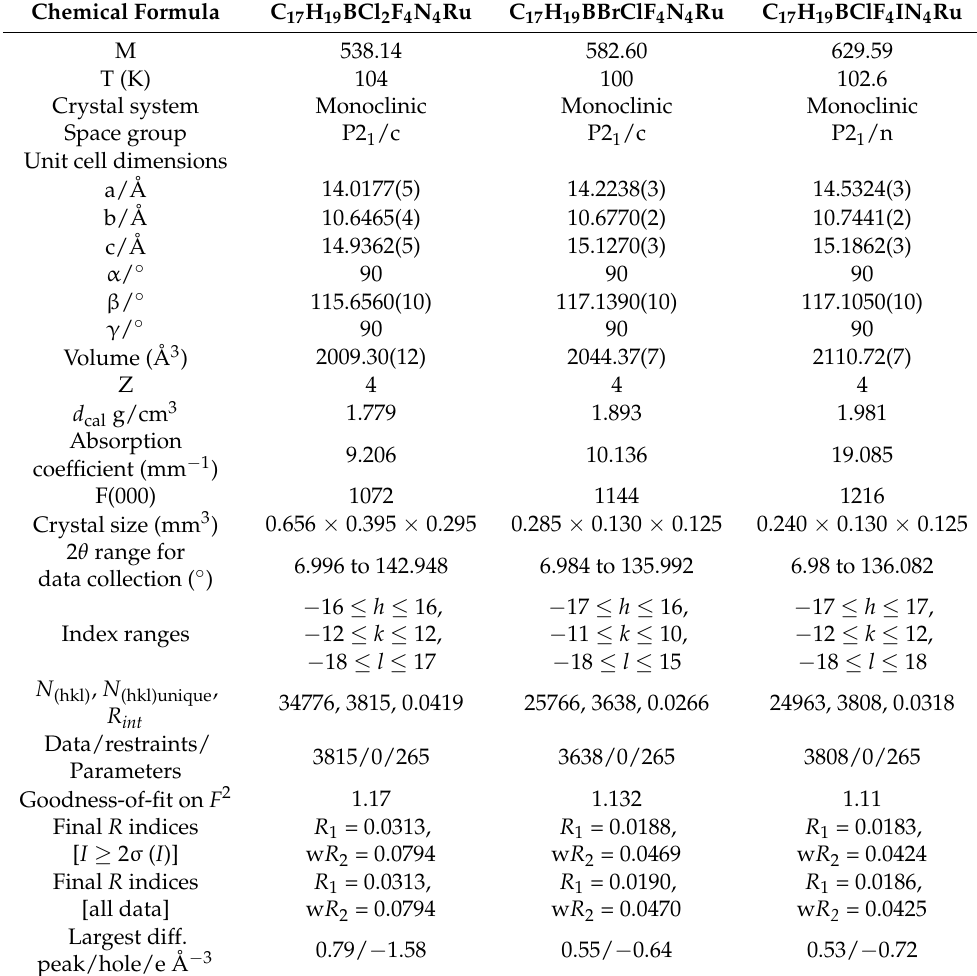
Table 1. Summary of the crystal metric data for Ru1-3 .